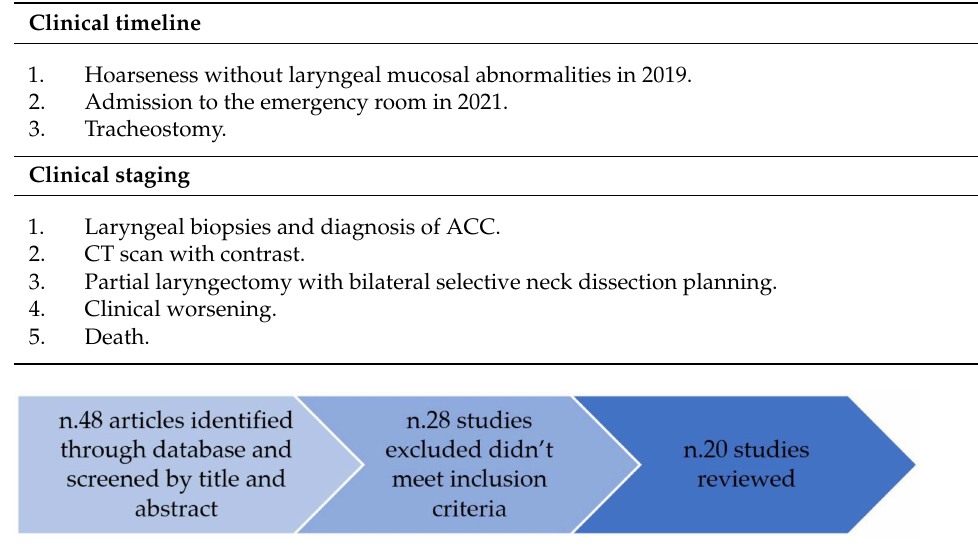
Figure 5. Articles selection on laryngeal adenoid cystic carcinoma. Primitive LACC is a rare head and neck carcinoma with slow growth but a high rate of malignancy due to its frequent perineural invasion. A high percentage of distant metastasis has been reported both at first diagnosis and during follow-up. The main distant metastasis site for LACC is the lung, but metastasis can develop in many sites. Iype et al. even described a case of an isolated scapular metastasis [8].